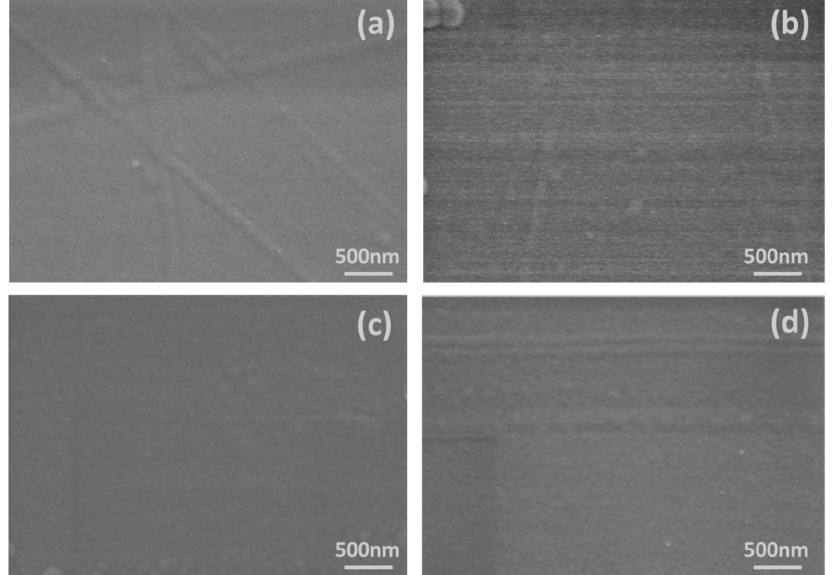
Figure 6. Surface topographies of siloxane coating ( a , c ) before the damp-heat test and ( b , d ) after the damp-heat test and adhesion test. ( a , b ) The 374 nm-thick the siloxane coating; ( c , d ) the 418 nm-thick siloxane coating.